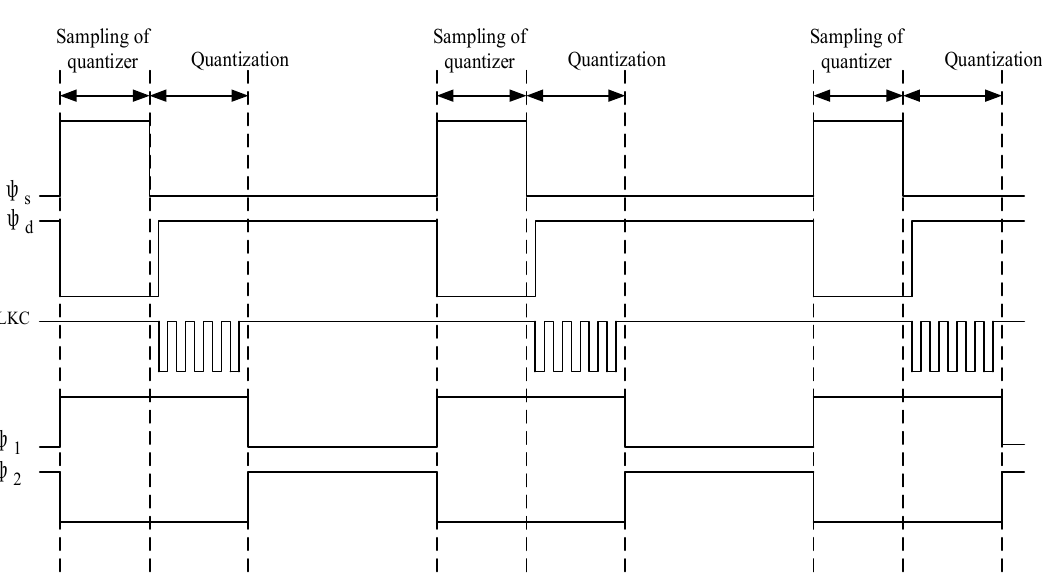
Figure 2. General circuit structure diagram.